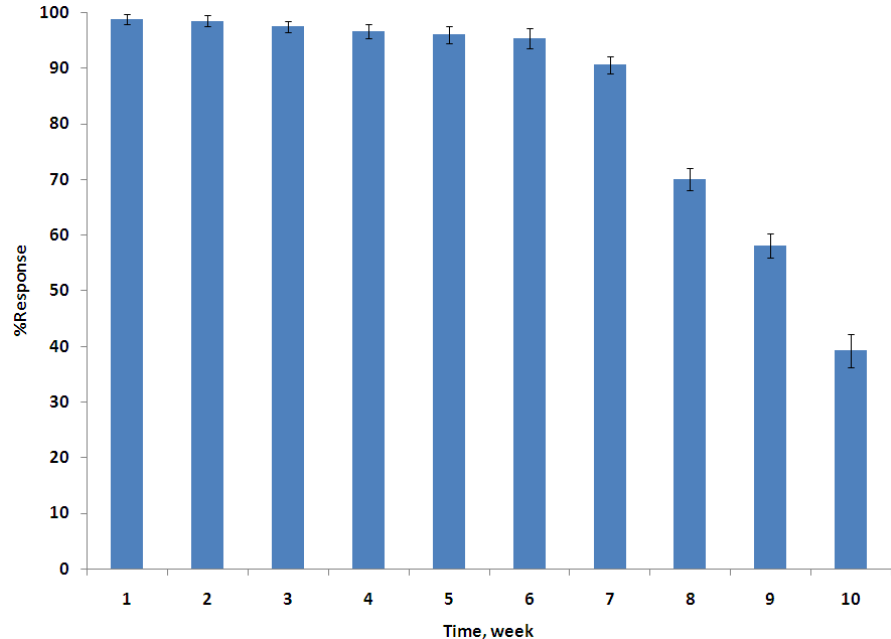
Figure 6. Stability of the AOX/PANI biosensor response (average of